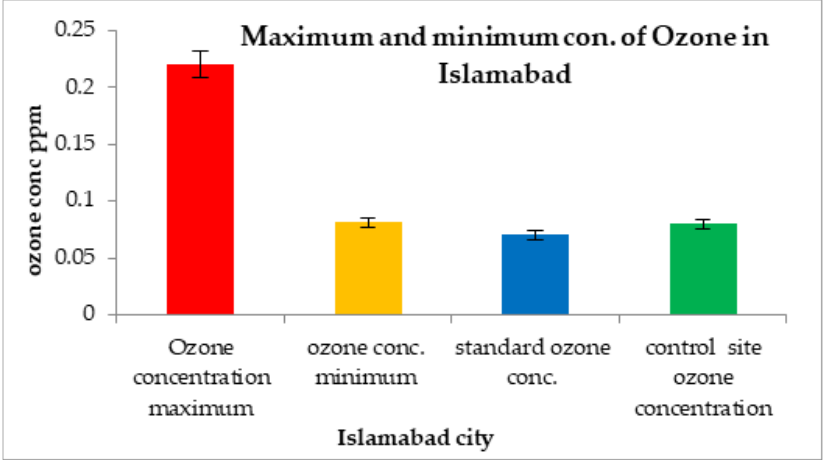
Figure 10. Comparison of maximum and minimum ozone concentrations with control sites and WHO standard values in Islamabad.